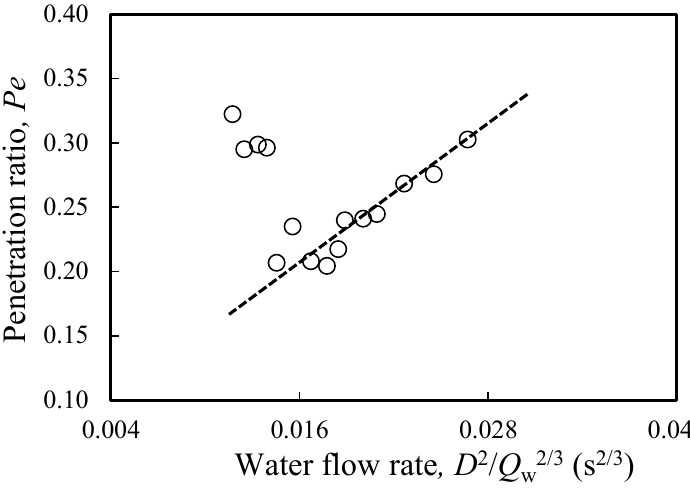
Figure 15. Penetration ratio (Pe) vs. water flow rates [72].